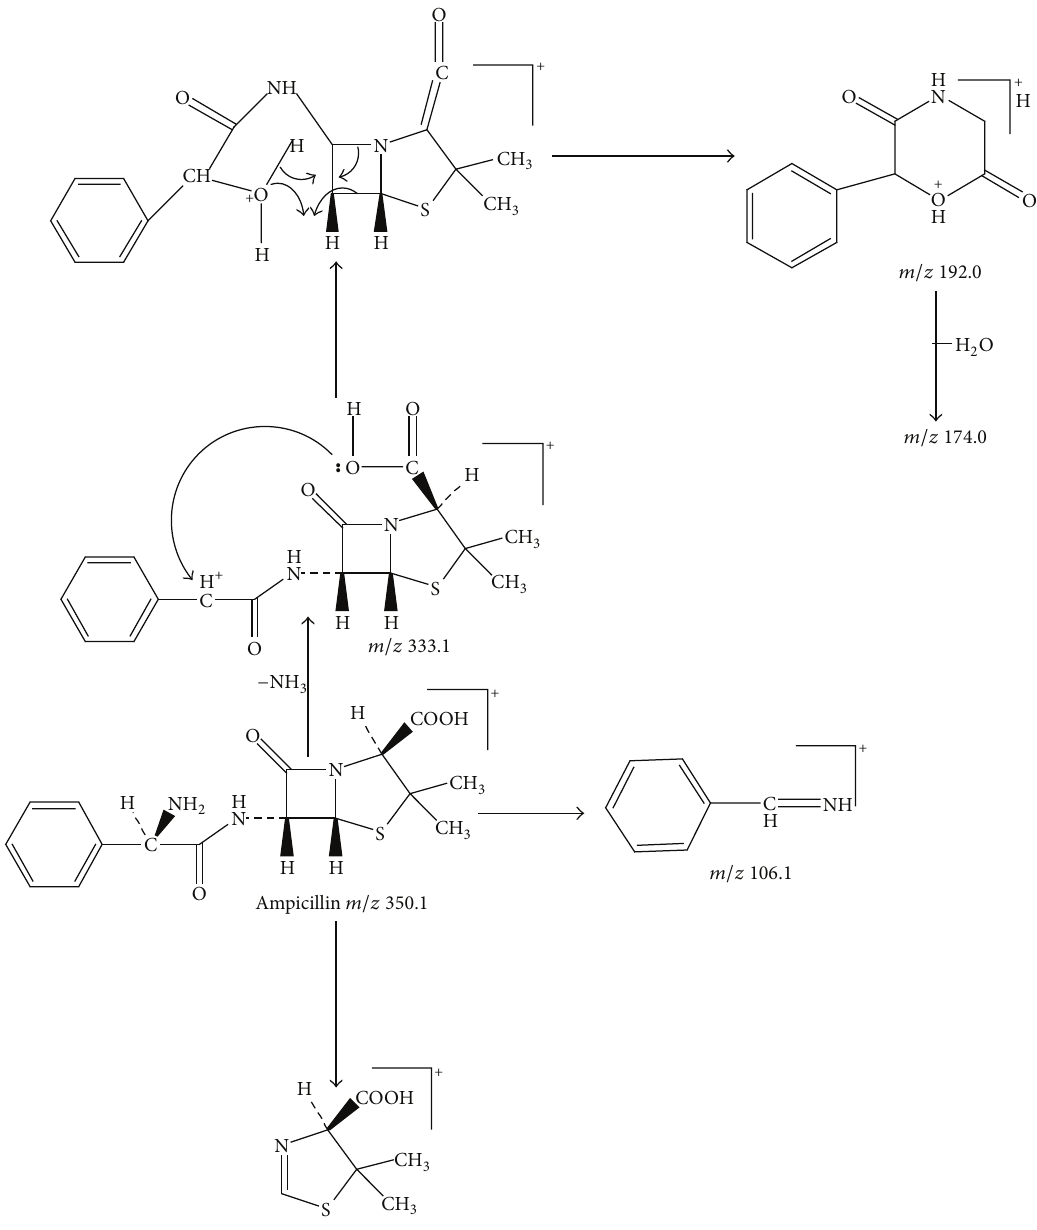
Figure 3: Proposed fragmentation pathways and characteristic ions of protonated ampicillin ( 𝑚/𝑧